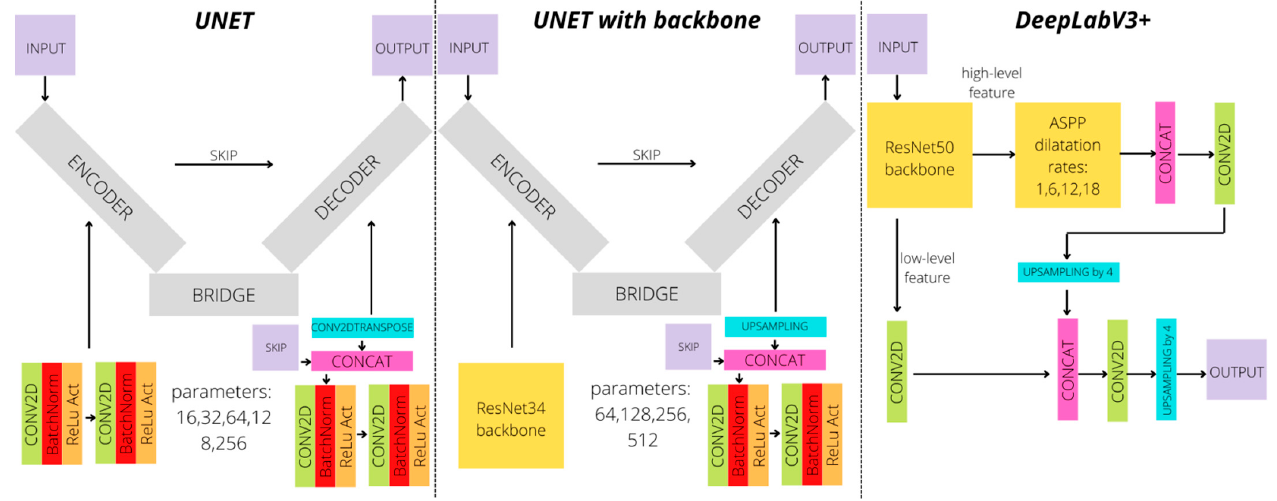
Figure 5. Used model architectures.